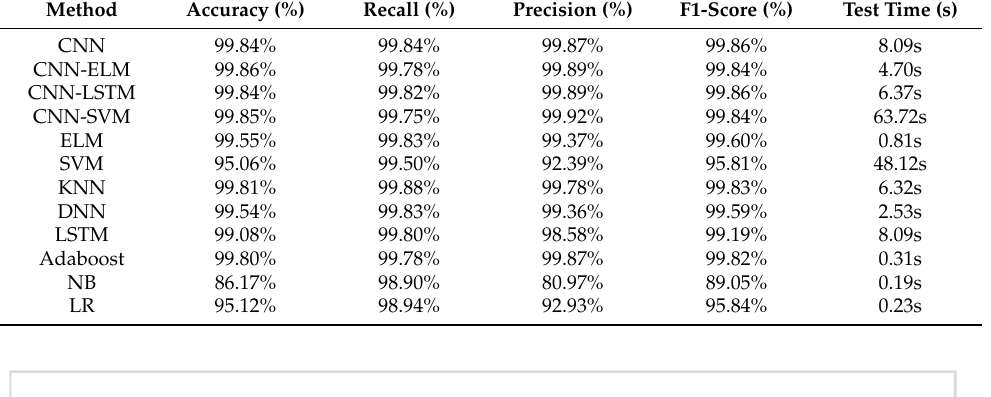
Table 10. Comparison results of CNN_ELM models of 48 feature subsets based on CICIDS- 2017 dataset.